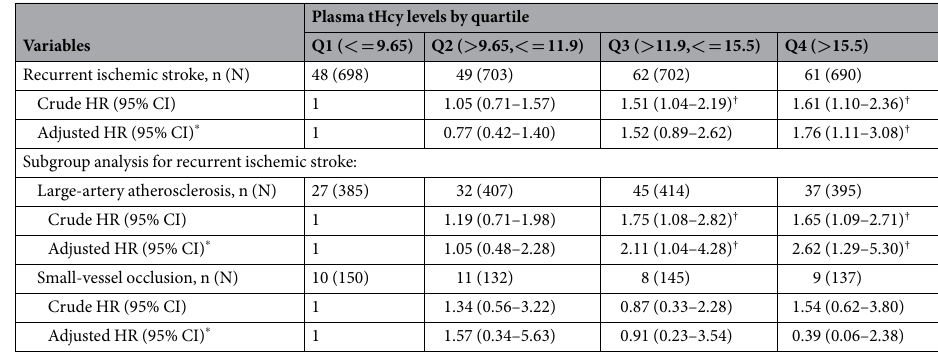
Table 5. Association of tHcy levels by quartile within three months of acute stroke and association with recurrent ischemic stroke ( μ mol/L). CI, confidence interval; HR, hazard ratio; and tHcy, total homocysteine. * Adjusted for age, sex, smoking status, low-density lipoprotein cholesterol level, high-sensitivity C-reactive protein level, Apolipoprotein B/Apolipoprotein AI ratio, and the presence of hypertension, type 2 diabetes mellitus, coronary artery disease, and obesity. † P < 0.05 as compared with